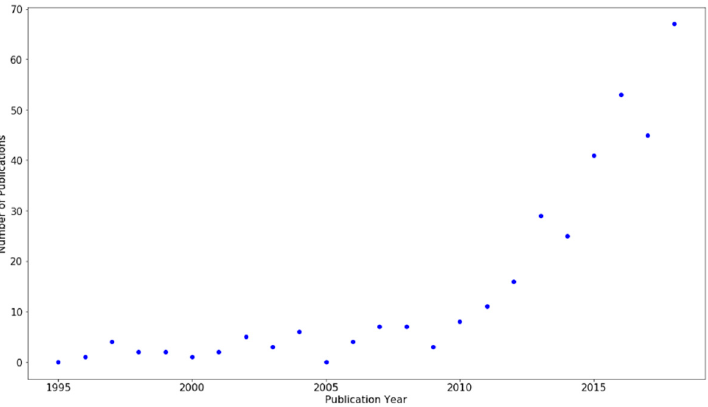
Figure 1. Number of publications returned for the search of ‘Bayes hydrology’ in Web of Science as of December 2019.